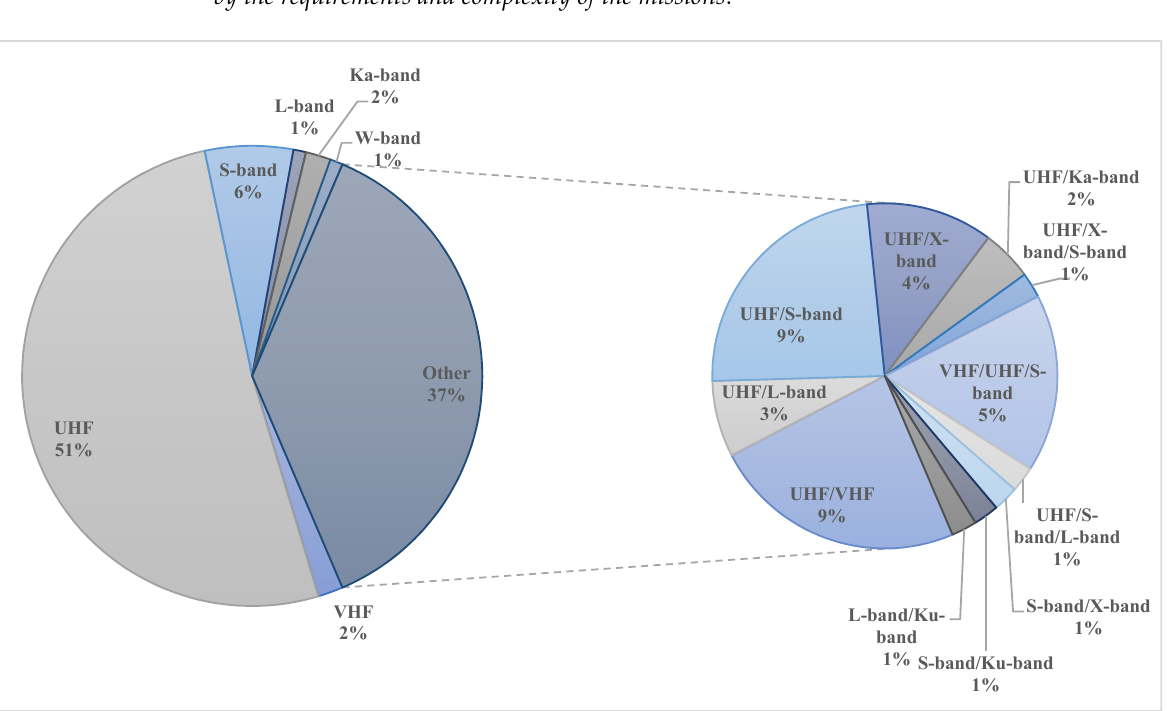
Figure 5. Antenna types used in the 120 CubeSat missions presented in Table 4.